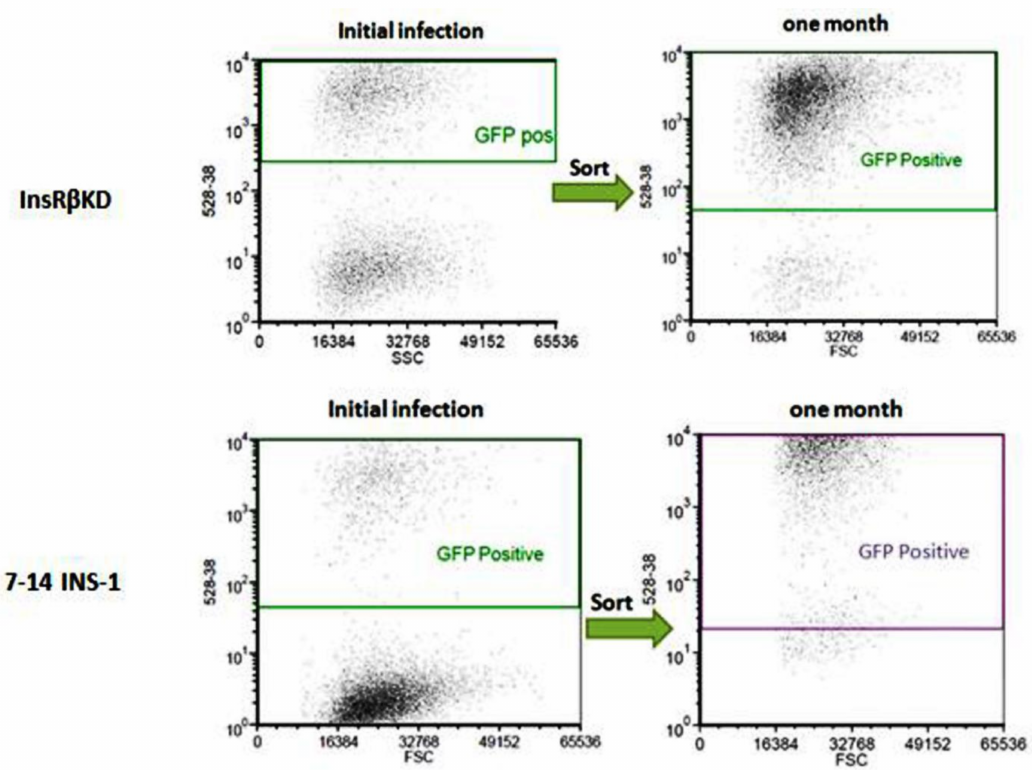
Figure 3. The stability of transduced INS-1 cells. After initial transductions of INS-1 cells with lentiviruses, GFP positive cells were sorted by FACS ( left panels ). After one-month culture of the positive cells, the InsR β KD and LV-7-14-INS-1 cells show high percentages of GFP-positive ( right panels ), suggesting the transduction is